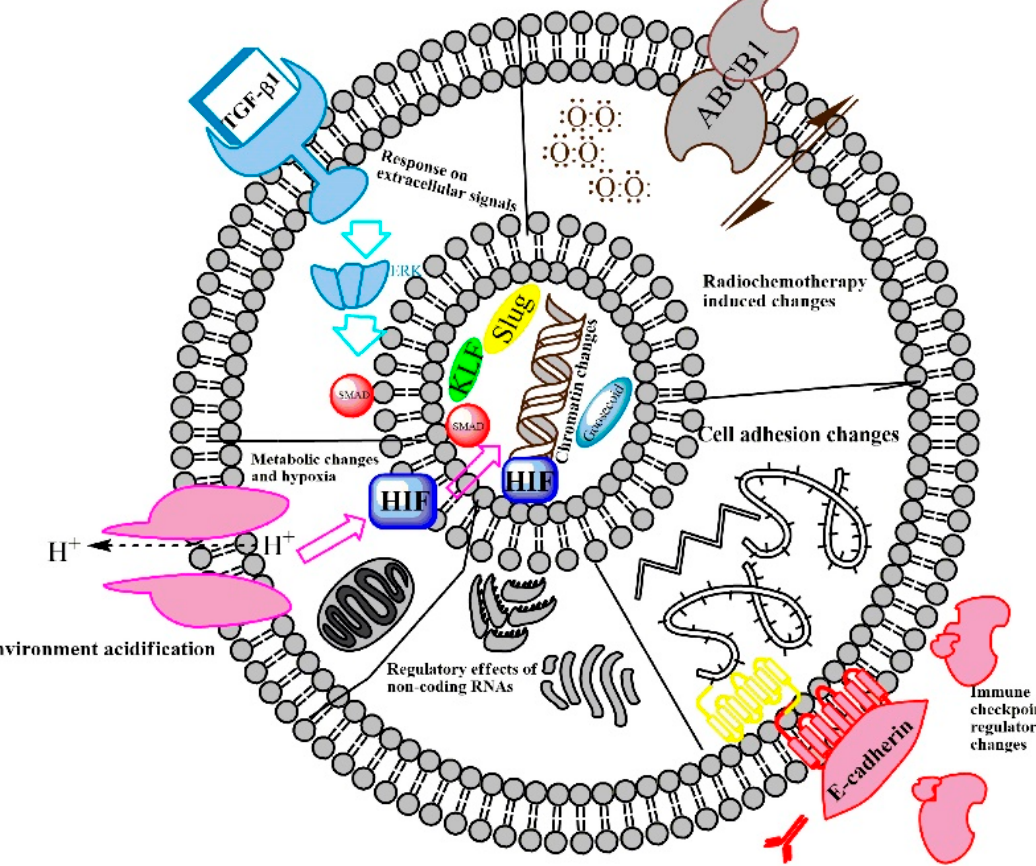
Figure 1. Main EMT regulatory mechanisms. EMT is a product of internal and external events in cells. It is mainly induced by external factors, such as TGF- β 1, neurotrophins, or interleukin-6, which activate several signaling pathways such as WNT, Smads, STATs, Akt, or Erk1/2. The activated pathways drive transcription factors (Goosecoid, Snail, Slug, Twist, nuclear factor erythroid-2-related factor 2 (NRF2), and Krüppel-like factors (KLFs)) to bind to special responding sequences in DNA, and, consequently, these mainly suppress the expression of genes related to epithelial differentiation. The best-known event in this process is the down-regulation of E-cadherin by the SNAI transcription factors, Snail, and Slug. At the same time, mesenchymal gene products, such as vimentin, are induced during the transcriptional changes in the EMT process, where the Smad, HIF-1 α , and KLF4 transcription factors are directly involved [43,44]. The transcription regulatory process during EMT